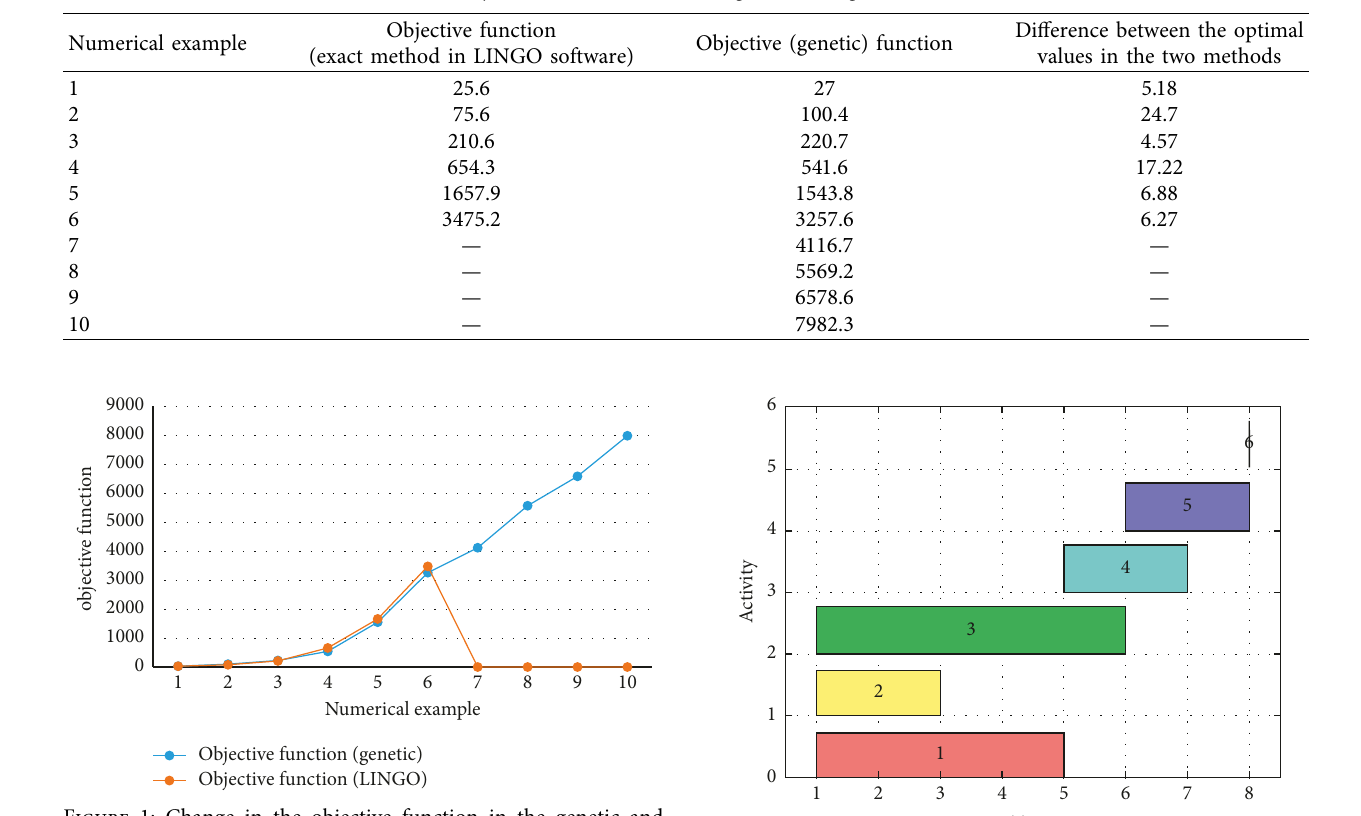
Table 3: Objective function values using exact and genetic methods.